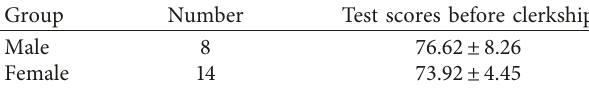
Table 1: Scores of the students before